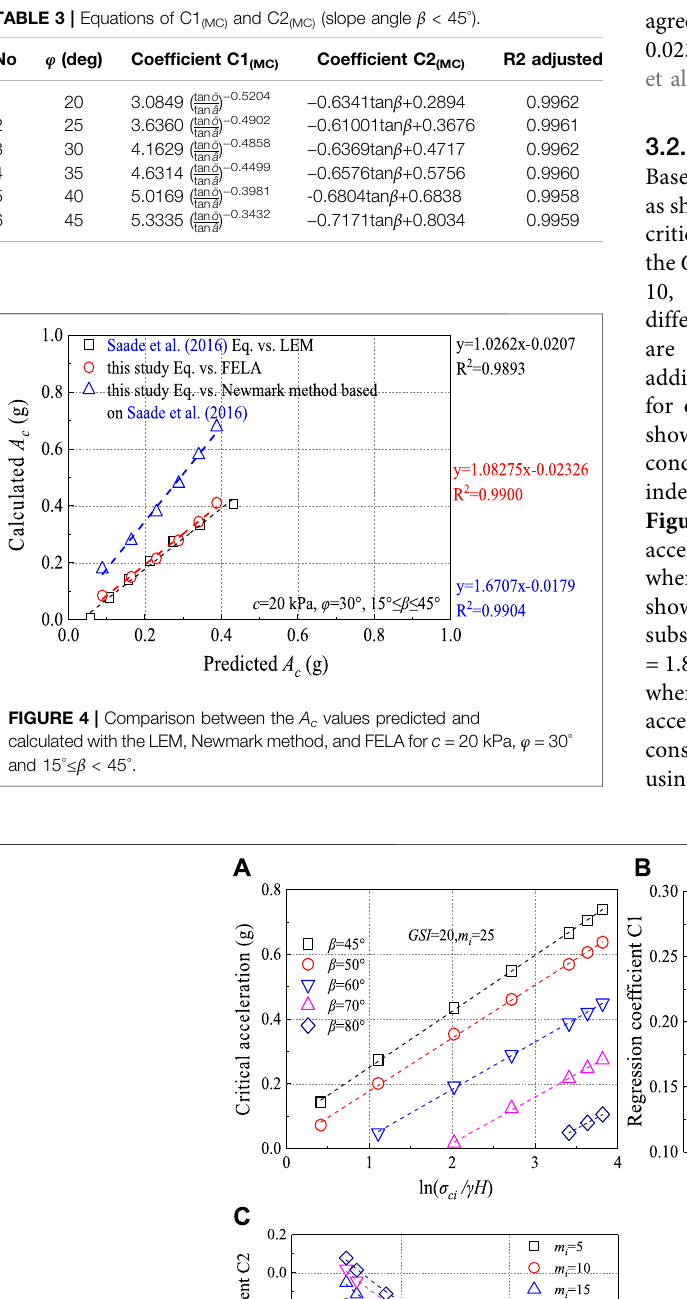
Frontiers in Earth Science |